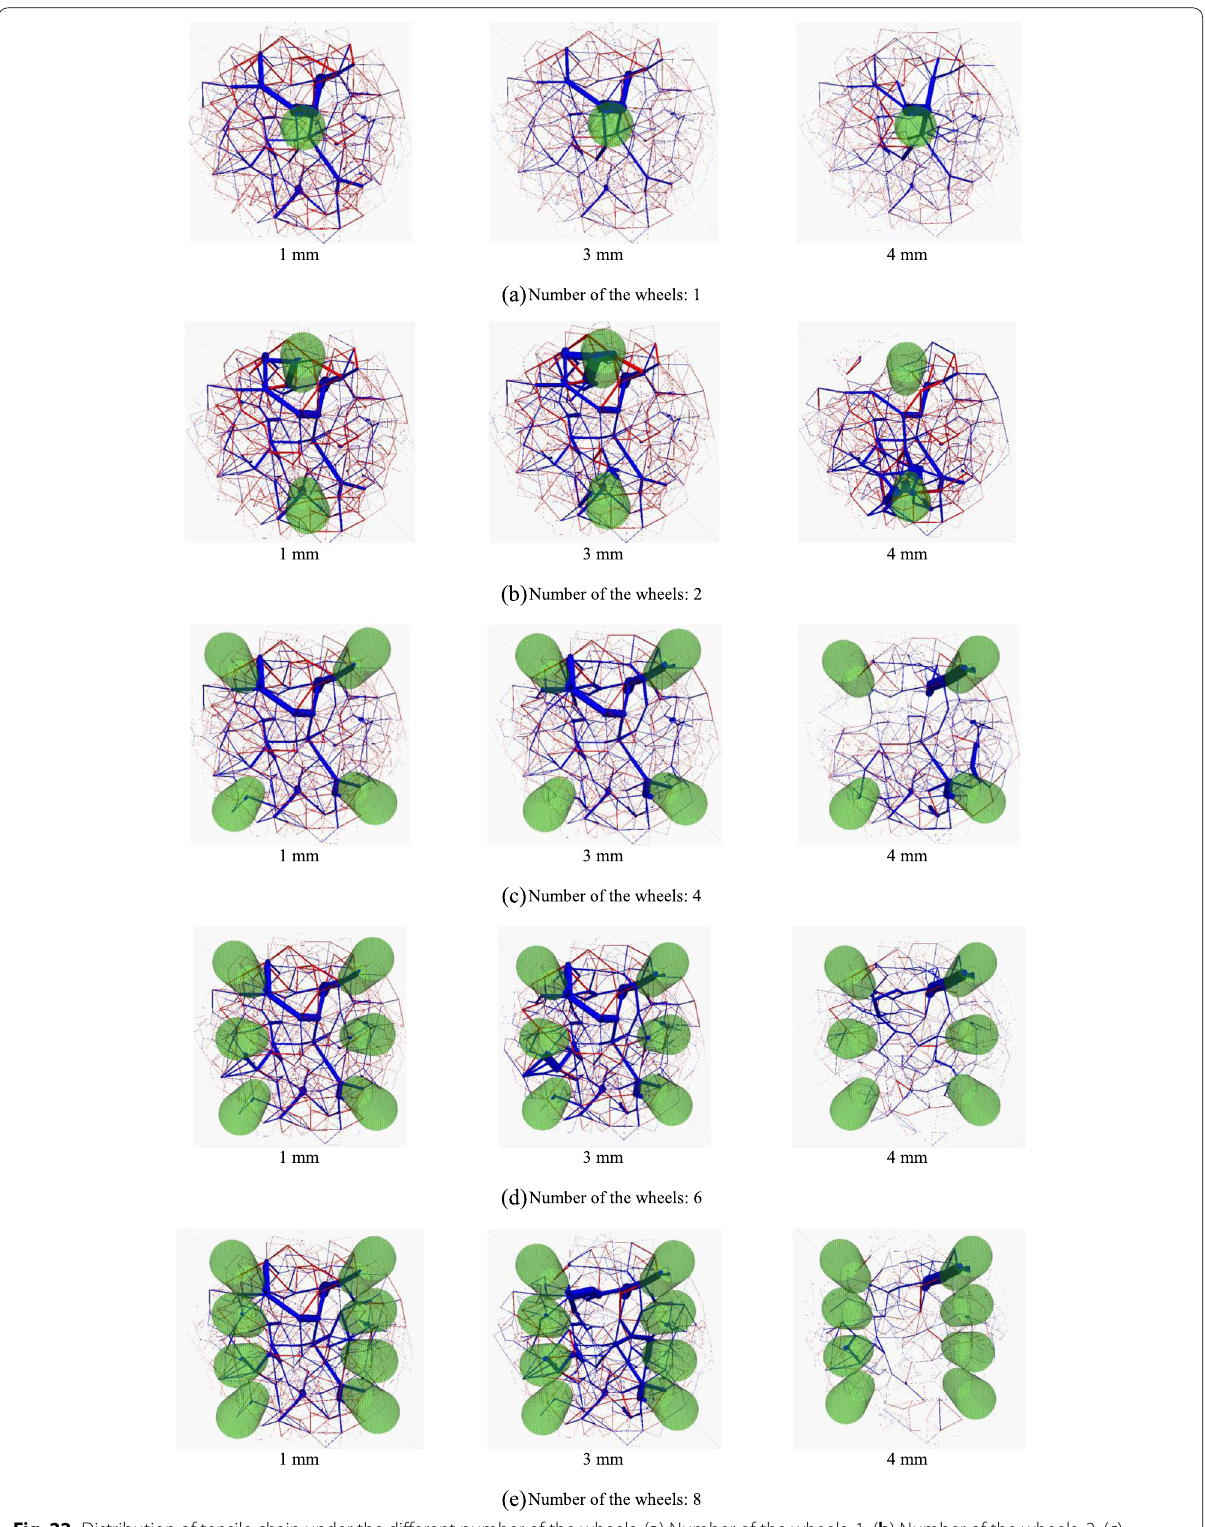
Fig. 22 Distribution of tensile chain under the different number of the wheels. ( a ) Number of the wheels: 1. ( b ) Number of the wheels: 2. ( c ) Number of the wheels: 4. ( d ) Number of the wheels: 6. ( e ) Number of the wheels: